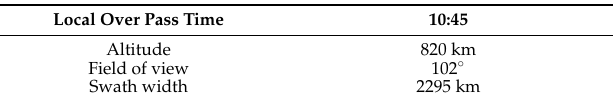
Table 2. Proba-V 300 m main characteristics.